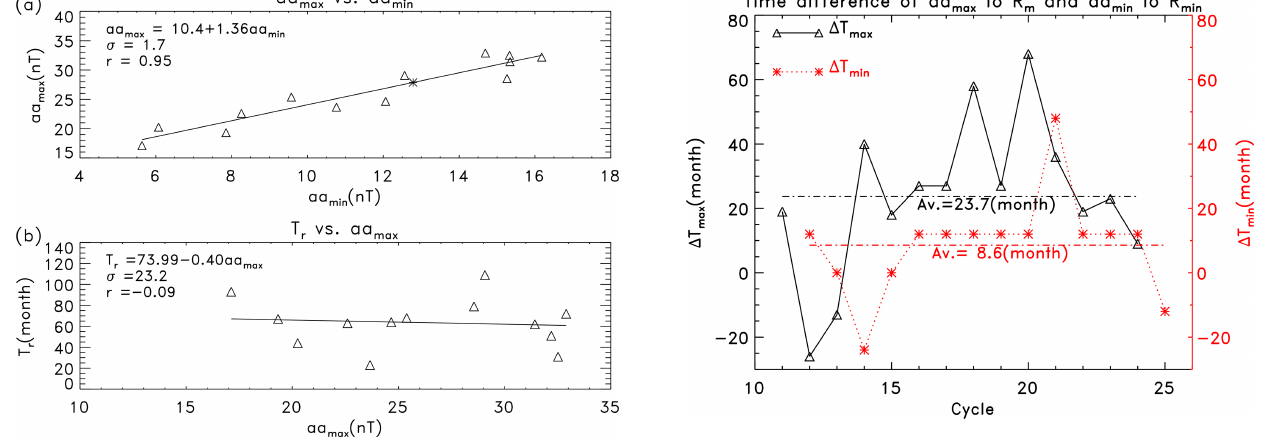
Figure 6. Scatter plots of aa max against aa min (a) and T r against aa max (b) .